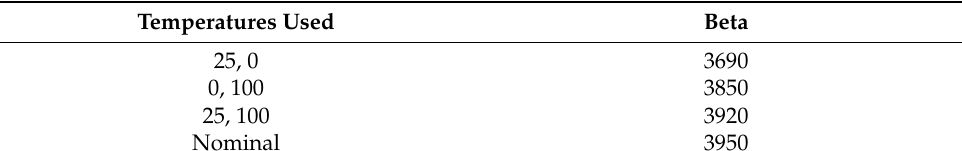
Table 5. Steinhart–Hart simplified model calibration.